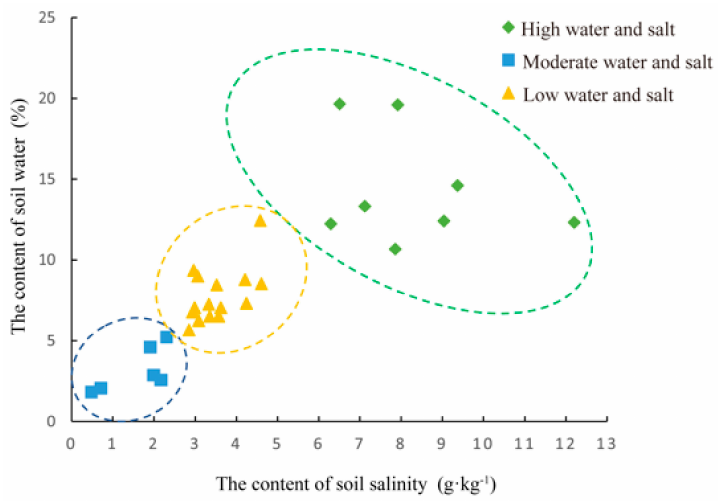
Figure 2. The Clustering results of water-salt gradient in sample